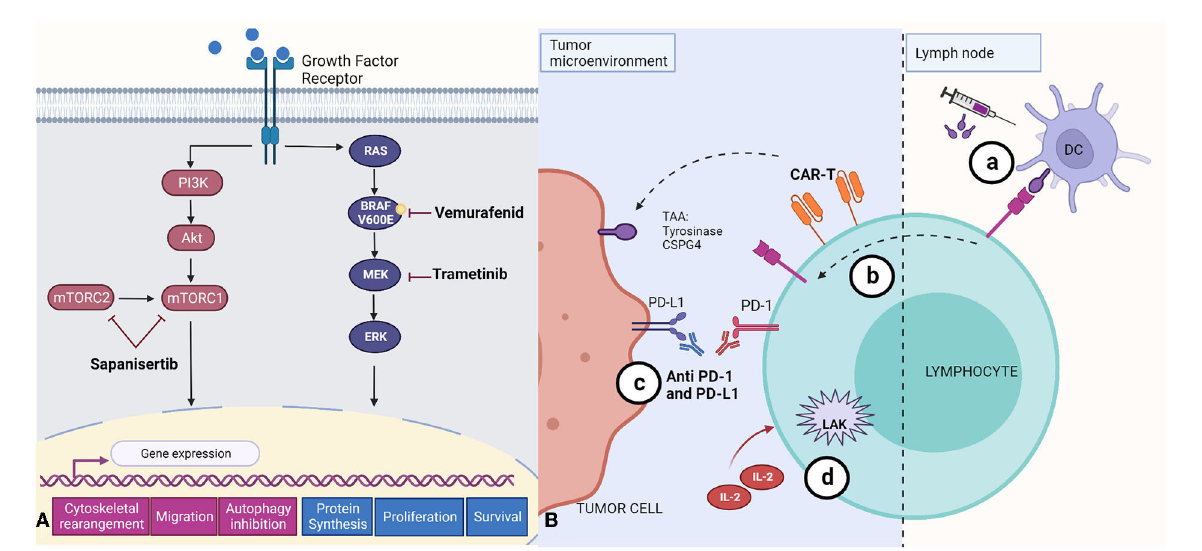
FIGURE3 Summary of small molecule- and antibody-based approaches to melanoma treatment. (A) Targeted therapies that aim to suppress central mechanisms of cellular proliferation and metastasis by inhibition of the mTOR (Sapanisertib), and MERK/ERK (Vemurafenid, Trametinib) pathways. The mTOR pathway activates gene expression that leads to cytoskeletal rearrangement, migration, and inhibition of autophagy. The RAS/BRAF/MEK/ERK pathway activation leads to increased protein synthesis, and promotes cell proliferation and survival. (B) Immunotherapies described to date in canine tumors. (a) Immunogens encoded by DNA vaccines, including tyrosinase (Oncept) or CSPG4, are first recognized by dendritic cells (DC) which later present antigen fragments to T cells at the lymph node; these T cell are able to target the antigen at the tumor microenvironment; (b) CAR-T cells engineered for specific tumor-associated antigens (TAAs) and cloned in vitro before being reincorporated into the patient; (c) Monoclonal antibodies recognizing PD-L1 blocking its binding with PD-1 receptor; and (d) Lymphokine-activated killer cells activated in vitro with IL-2. Created with